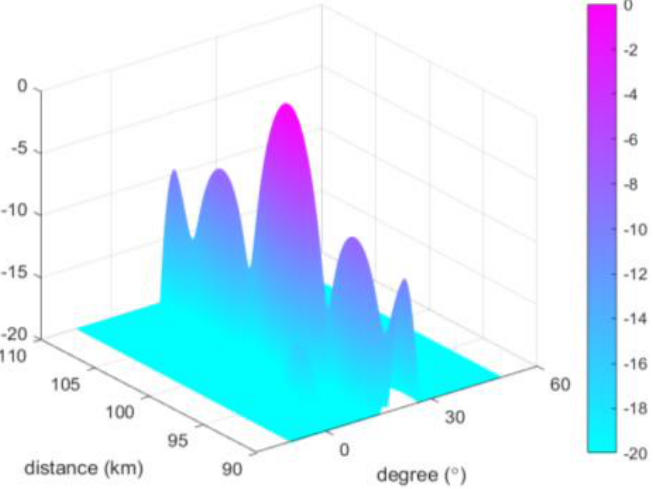
Figure 5. The 3D beam pattern.